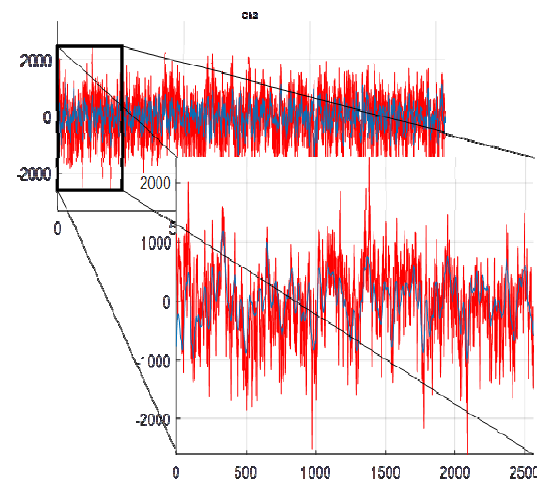
Fig. 2. The EEG activities for the first control healthy subject .